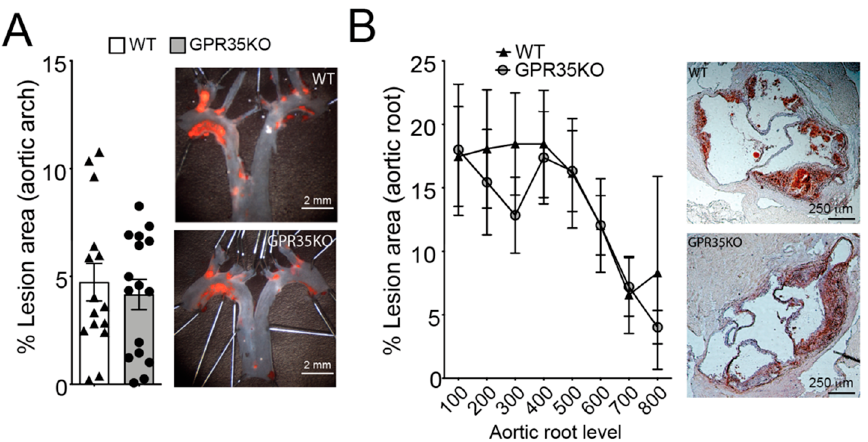
Figure 2. Ablation of GPR35 signaling in bone marrow-derived cells does not influence atherosclerosis. Thirteen week-old LdlrKO mice reconstituted with GPR35KO , and WT mice bone marrows were fed WD for 8 weeks. ( A ) Dissected aortic arches were stained with Sudan IV en face and % lesion areas of total vessel area are shown. Representative stained samples from each group are shown on right panels; n = 16 and 15, for GPR35KO and WT groups, respectively. Results are mean ± SEM. ( B ) Percentage atherosclerotic lesion area in the proximal aorta of male transplanted LdlrKO; n = 8 and 6, for GPR35KO and WT groups, respectively. Data show means of each of the 8 cross-sectional lesion sizes for the animals in the same group. Right panels show representative micrographs from each group. Pooled data from 2 independent experiments is shown. No significant differences were observed ( A , Mann–Whitney; B , Two-way ANOVA).